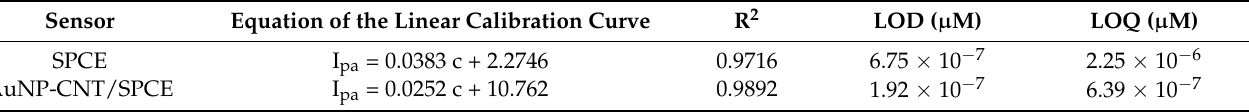
Table 4. The equations of linear fitting I pa vs. c, R 2 , LOD and LOQ values for the two sensors for atorvastatin detection. Sensor Equation of the Linear Calibration